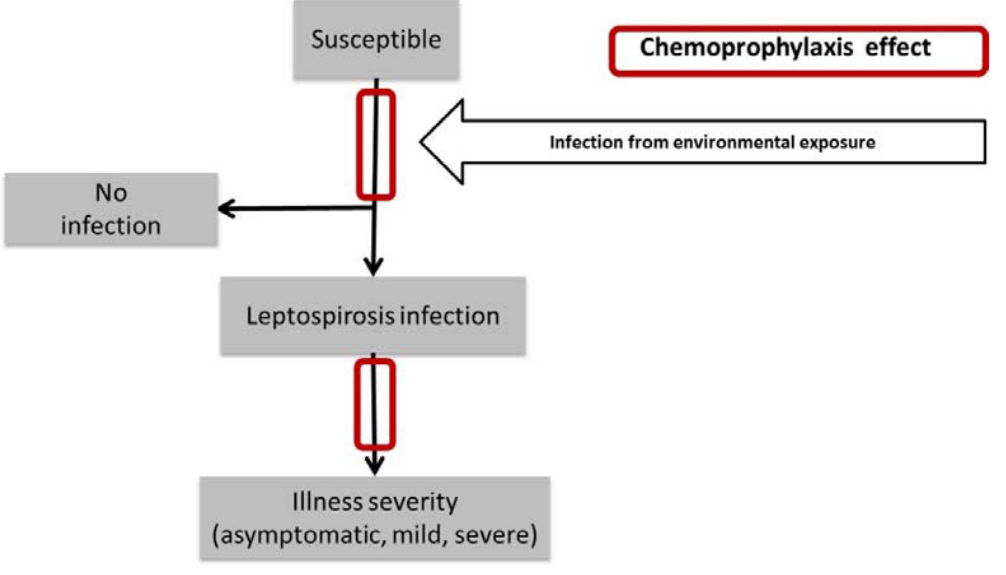
Figure 1. Conceptual diagram of the potential effect of chemoprophylaxis on the dynamics of a leptospirosis outbreak and its health impact.